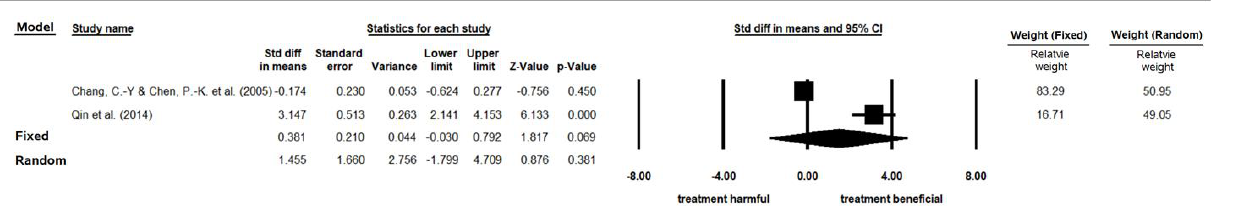
Table 14. Original data of the studies examining the influence of indoor plants on attention.